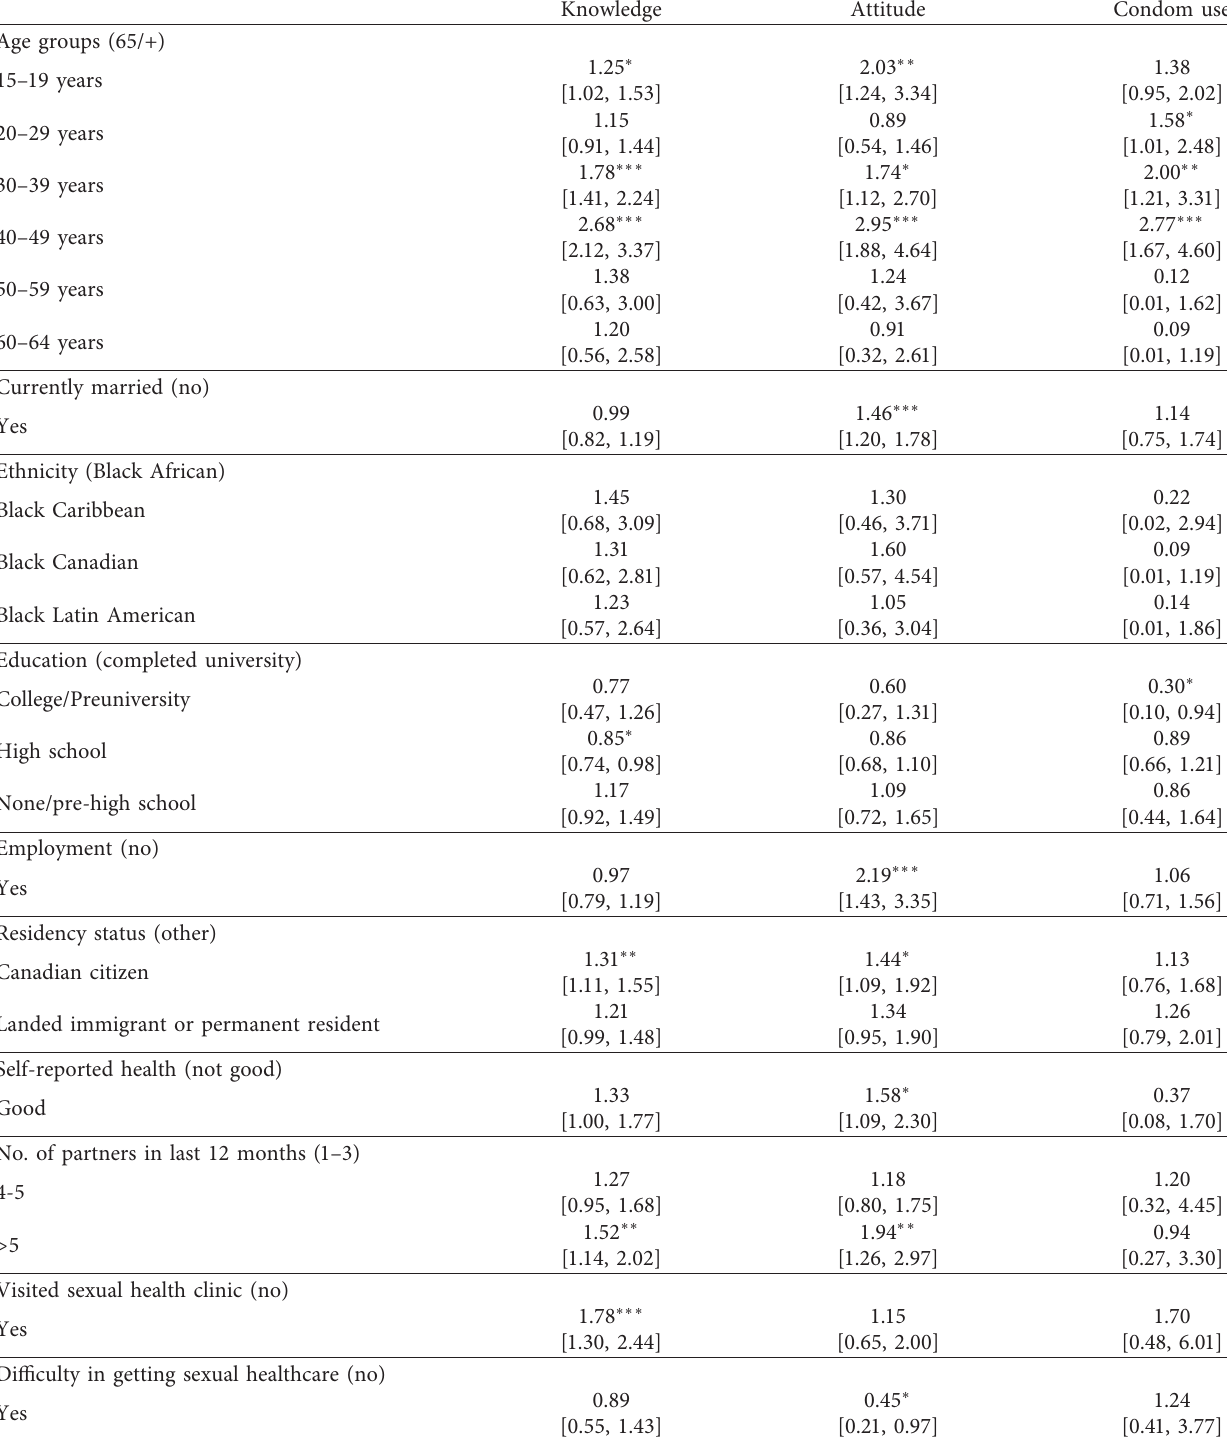
Table 2: Factors associated with condom knowledge, attitude, and use among ACB men in